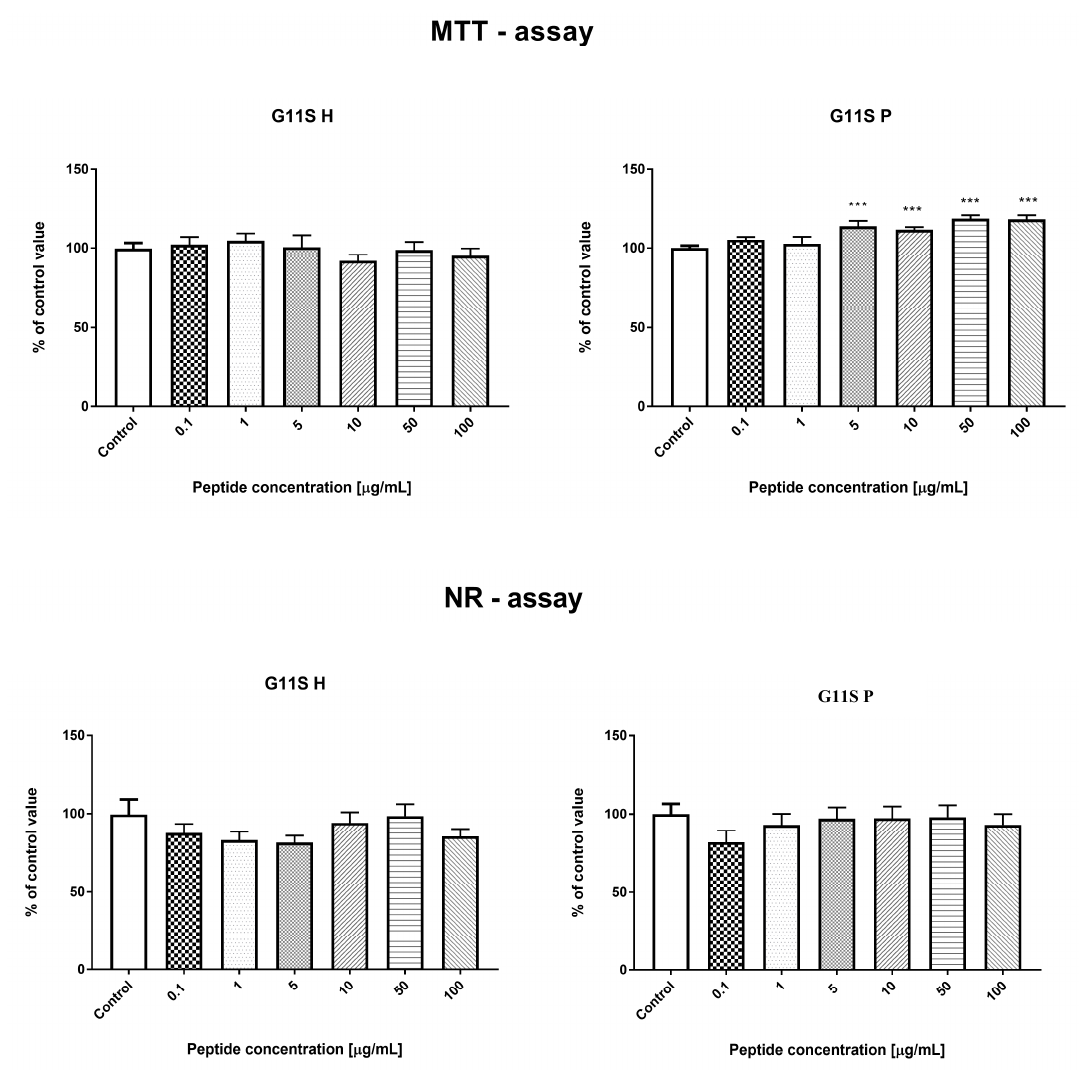
Figure 4. Result of MTT and NR tests for globulin hydrolyzate (G11S H) and globulin peptide fraction (G11 P). *** p < 0.001